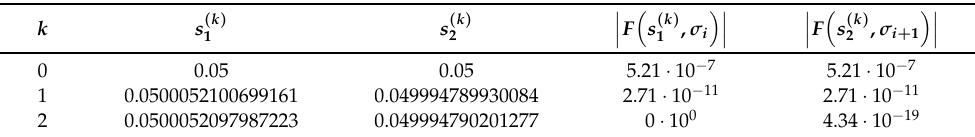
Table 1. Initial guess ( k = 0) and refinements of external integration domain splitting points along with the corresponding residual values for a semi-circular curve parametrized by C ( s ) = ( cos ( s ) ,sin ( s )) , e = [ 0,0.1 ] , ∆ = 0.05. i hk